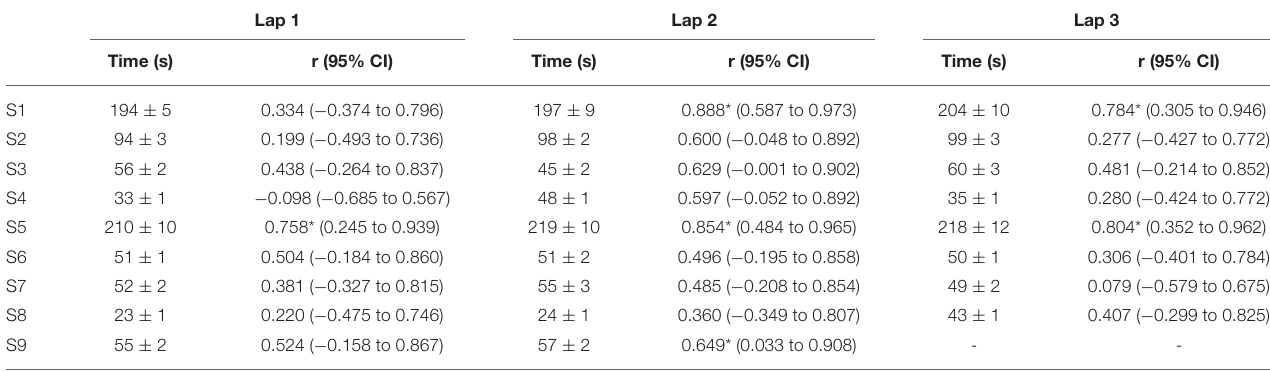
TABLE 3 | Mean ± standard deviation section times (s) and Pearson correlation coefficients (r) between section times and total race time, with the associated 95% confidence interval (CI), for the men ( n = 10). Lap 1 Lap 2 Lap